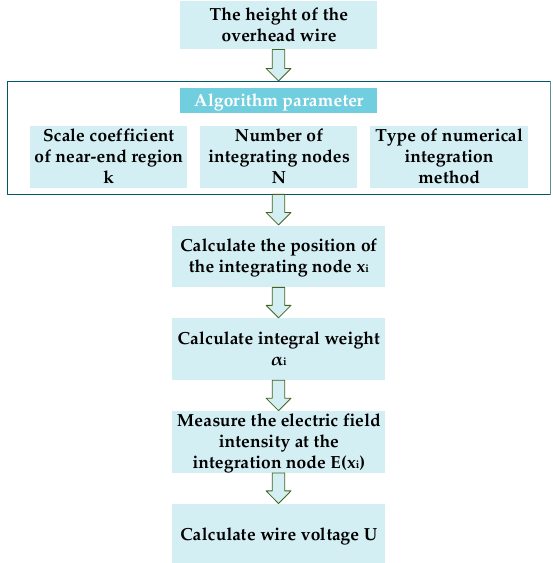
Figure 5. The flow chart of the line-voltage inversion algorithm.